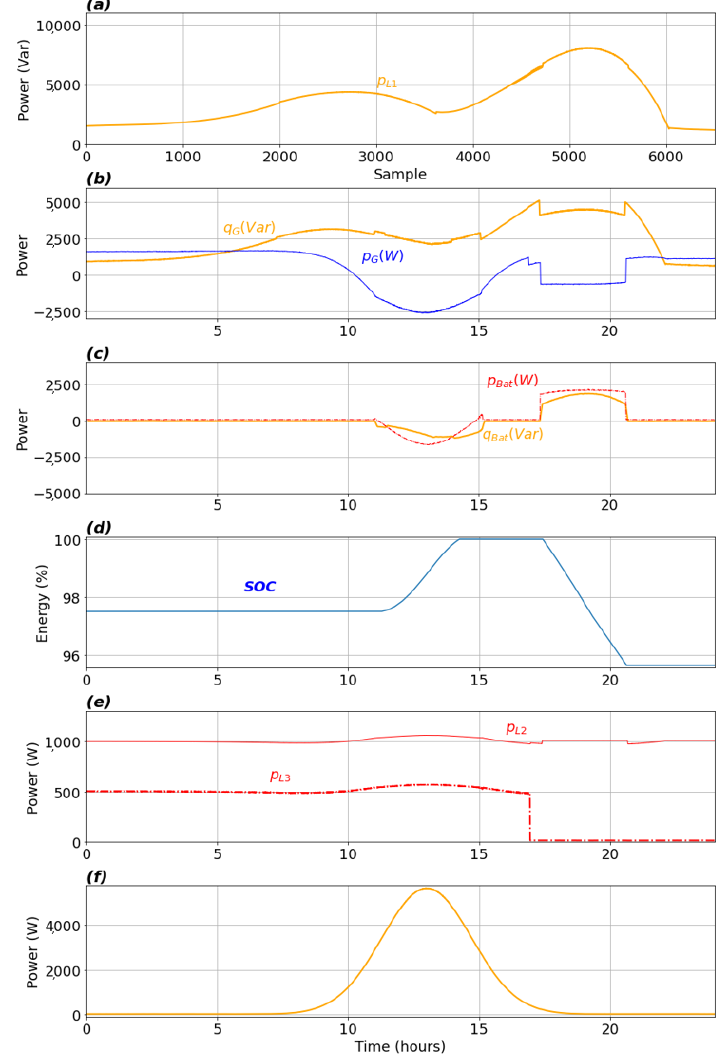
Figure 25. MG operating in connected mode with reactive power consumption. Power values: ( a ) Main load reactive power; ( b ) Main grid power; ( c ) Battery bank power; ( d ) Battery storage level; ( e ) Load 2 and 3 active power; ( f ) Photovoltaic active